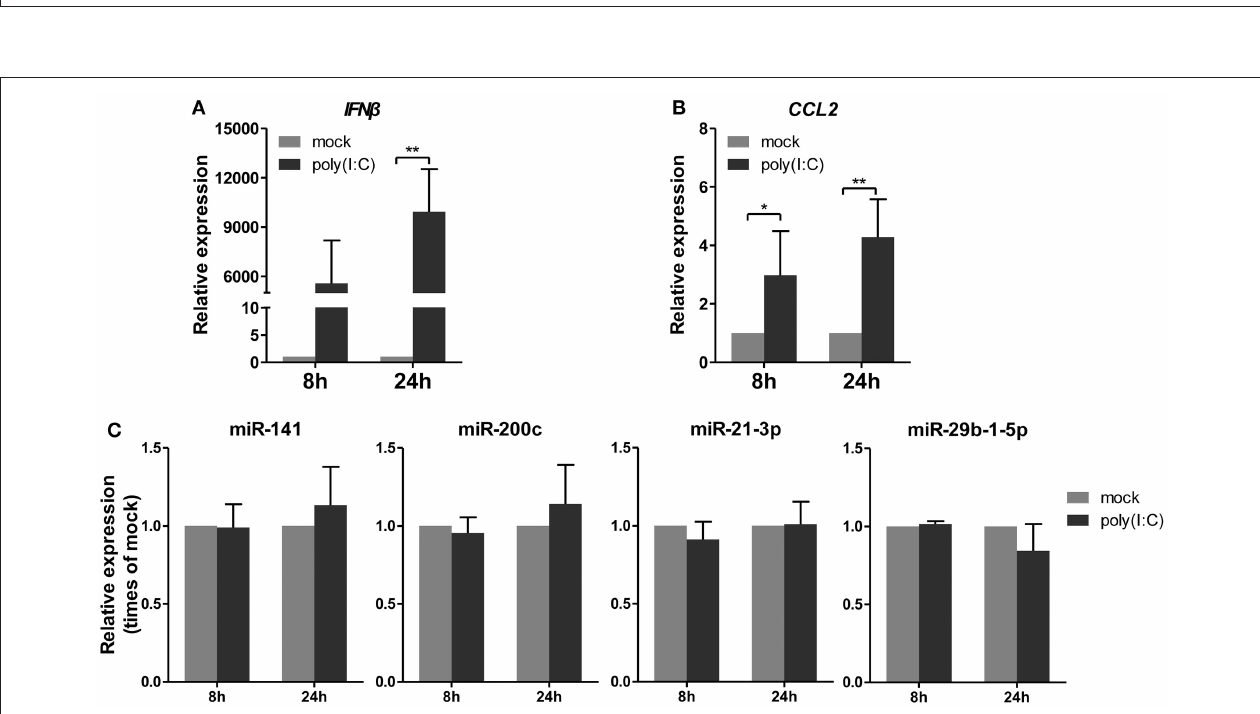
FIGURE 4 | Poly(I:C) does not regulate expression of miRNAs. A549 cells were stimulated with 10 µ g/ml poly(I:C) or mock treated for the indicated times. (A,B) Expression levels of IFN β and CCL2 were detected by real-time qPCR analysis to verify response to poly(I:C) stimulation. Samples were normalized to expression of GAPDH and relative to mock-infected cells. (C) Expression of miR-141, miR-200c, miR-21-3p, and miR-29b-1-5p was determined via real-time qPCR. Samples were normalized to expression of U6 snRNA and relative to mock-infected cells. Data are the mean ± SD from four independent experiments. * P < 0.05 and ** P < 0.01 vs. mock infection by t